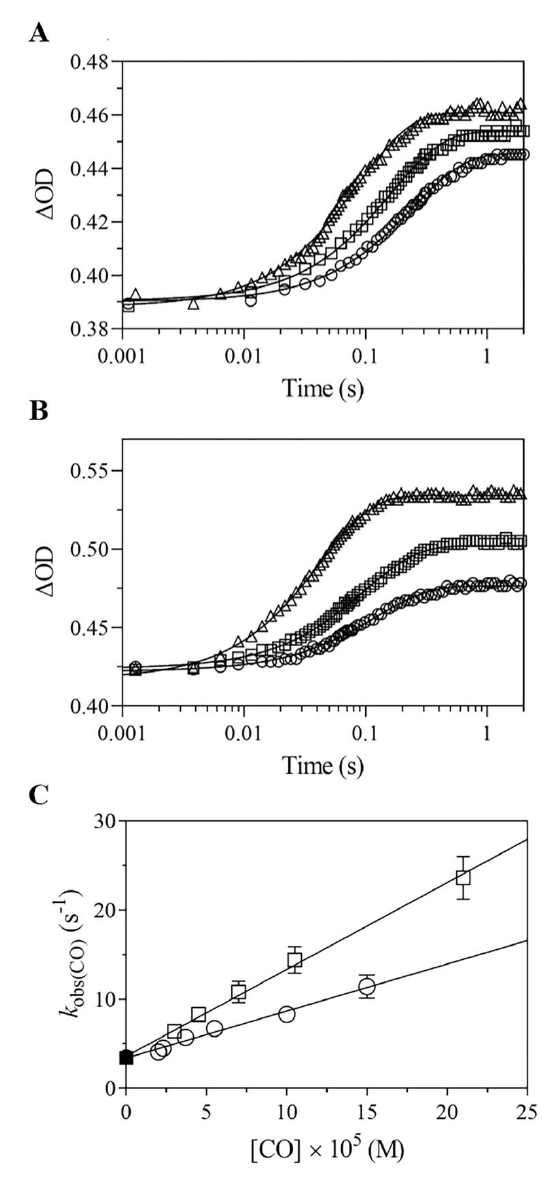
Figure 3. CO binding to Mt -Nb(II) and Hs -Nb(II), at λ = 421 nm, pH 7.0 and 25.0 °C. ( A ) Time course of CO binding to Mt -Nb(II) at [CO] = 2.0 × 10 − 5 M (circles), [CO] = 5.5 × 10 − 5 M (squares), and [CO] = 1.5 × 10 − 4 M (triangles). The analysis of the time courses according to Equation (1) allowed to determine the following values of k obs(CO) : 4.1 ± 0.4 s − 1 (circles), 6.7 ± 0.8 s − 1 (squares), and (1.1 ± 0.1) × 10 1 s − 1 (triangles). R -squared values for CO binding to Mt -Nb(II) are 0.996 (circles), 0.996 (squares), and 0.995 (triangles). ( B ) Time course of CO binding to Hs -Nb(II) at [CO] = 4.5 × 10 − 5 M (circles), [CO] = 7.0 × 10 − 5 M (squares), and [CO] = 2.1 × 10 − 4 M (triangles). The analysis of the time courses according to Equation (1) allowed to determine the following values of k obs(CO) : 8.3 ± 0.9 s − 1 (circles), (1.1 ± 0.1) × 10 1 s − 1 (squares), and (2.4 ± 0.3) × 10 1 s − 1 (triangles). R -squared values for CO binding to Hs -Nb(II) are 0.993 (circles), 0.993 (squares), and 0.998 (triangles). ( C ) Dependence of the k obs(CO) for Mt -Nb(II) (circles) and Hs -Nb(II) (squares) carbonylation on the CO concentration. Continuous lines were obtained according to Equation (2) with data reported in Table 1. p values for CO binding to Mt -Nb(II) and Hs -Nb(II) are <0.0001. Filled symbols on the ordinate indicate values of k off(CO) for the NO-dependent conversion of Mt -Nb(II)-CO (filled circles) and Hs -Nb(II)-CO (filled squares) to Mt -Nb(II)-NO and Hs -Nb(II)-NO,